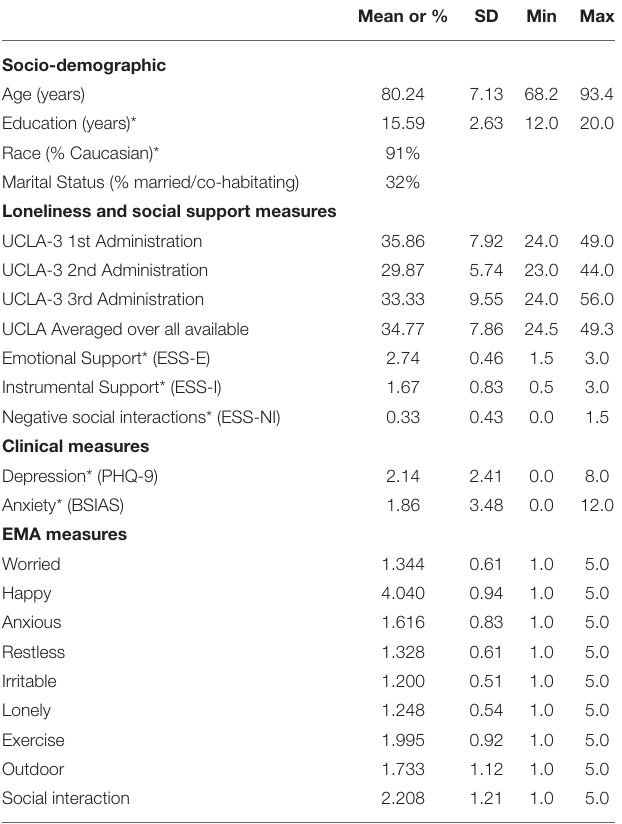
TABLE 1 | Socio-demographic and clinical factors ( N =